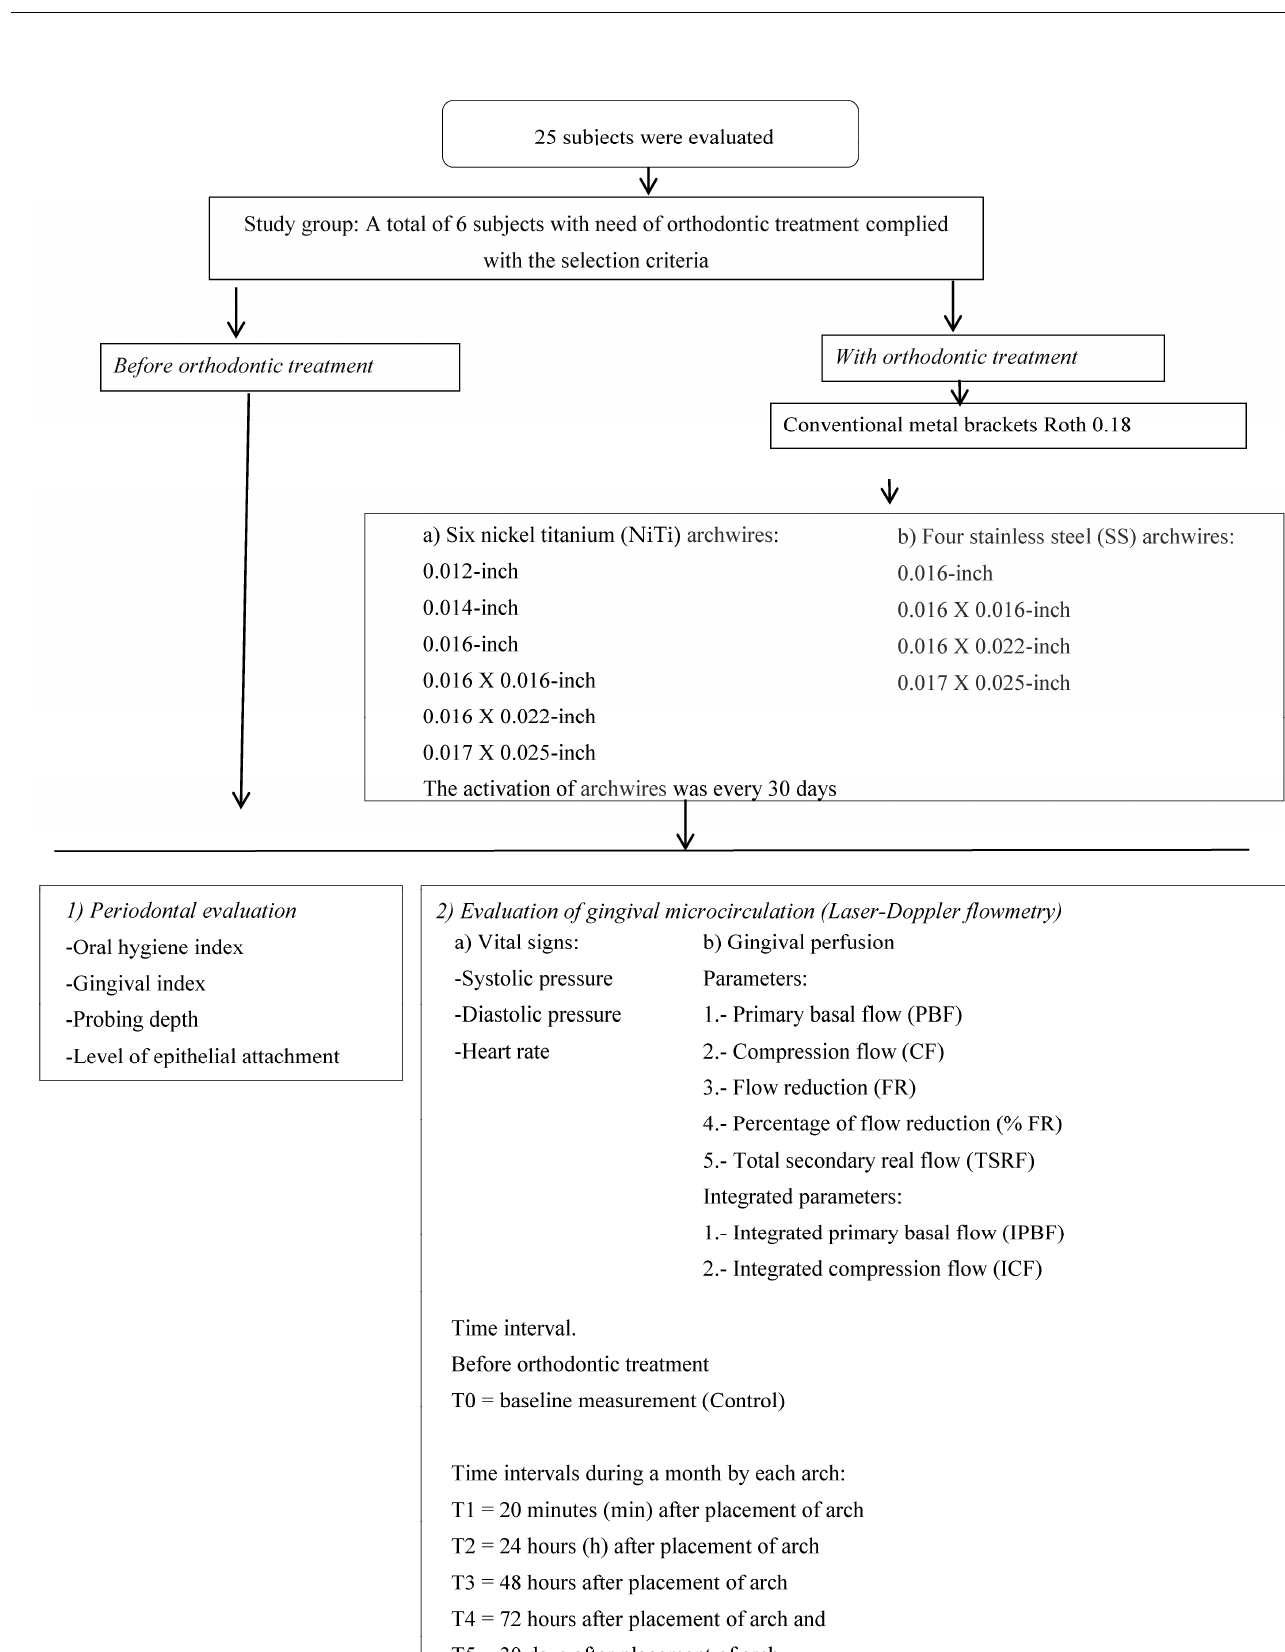
Figure 1. Protocol of the evaluation for periodontal tissues and gingival microcirculation using laser Doppler flowmetry in patients before and during orthodontic treatment.